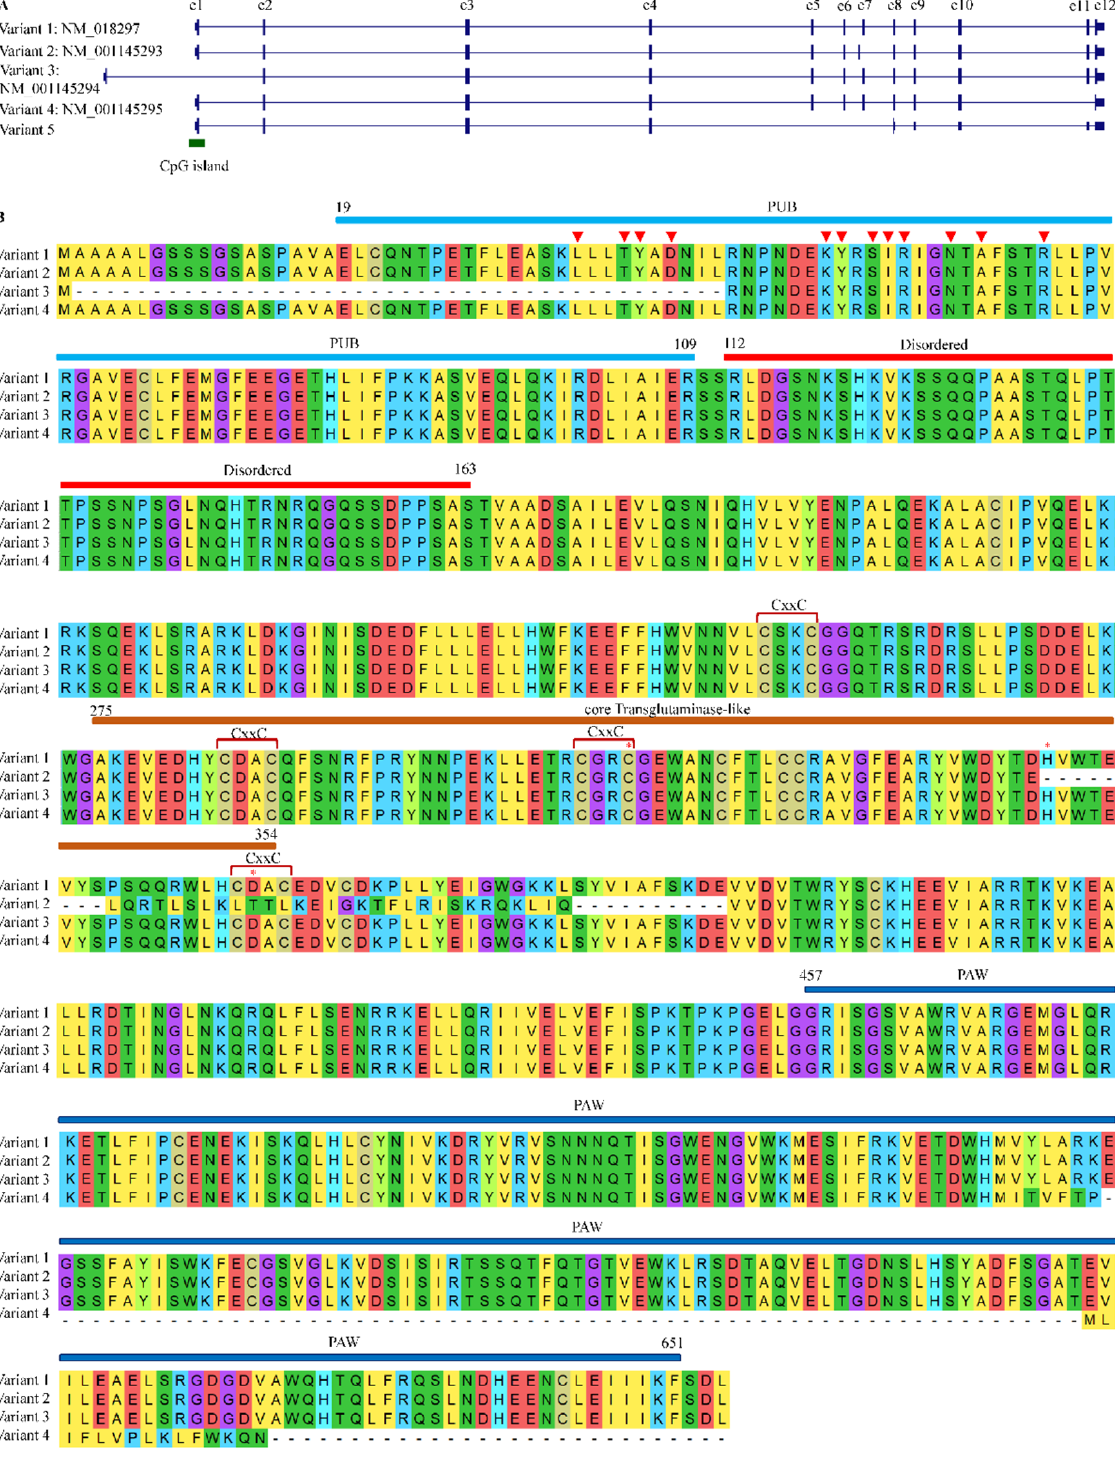
Figure 6. Variants of NGLY1 generated by alternative splicing in humans. ( A ) Transcripts; ( B ) Protein alignments. Red triangles represent peptide binding sites; Red stars the Cys-His-Asp catalytic triad.